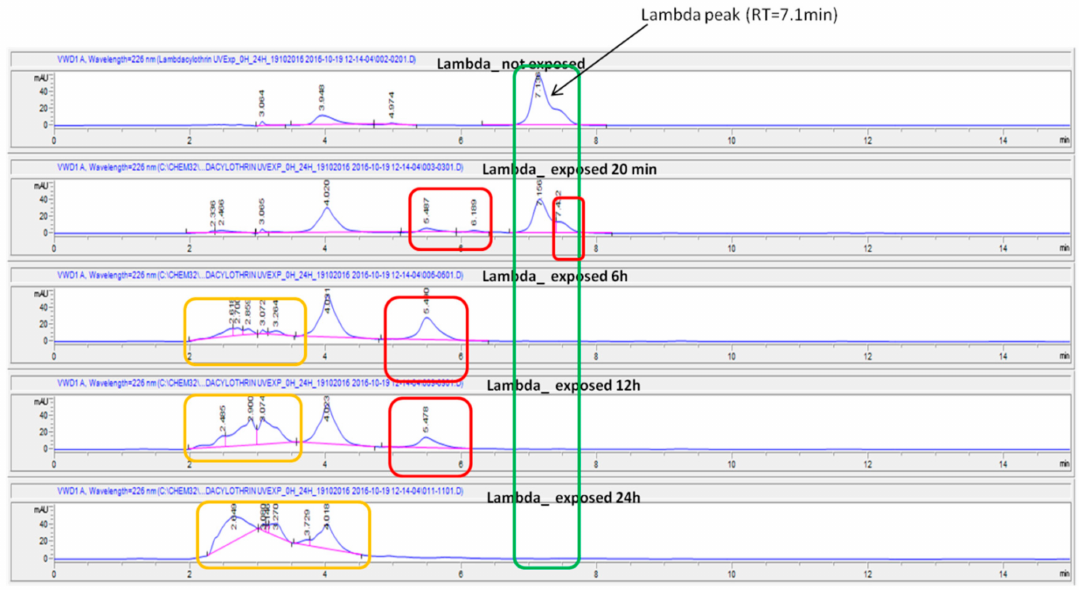
Figure 8. Chromatograms of the UV photolysis of λ -cyhalothrin at various exposure time intervals. The residues of λ -cyhalothrin are in the green box and the suspected metabolites in other boxes. 3.6.3. Effect of Alkaline Solutions (Hydrolysis) on λ -Cyhalothrin Degradation